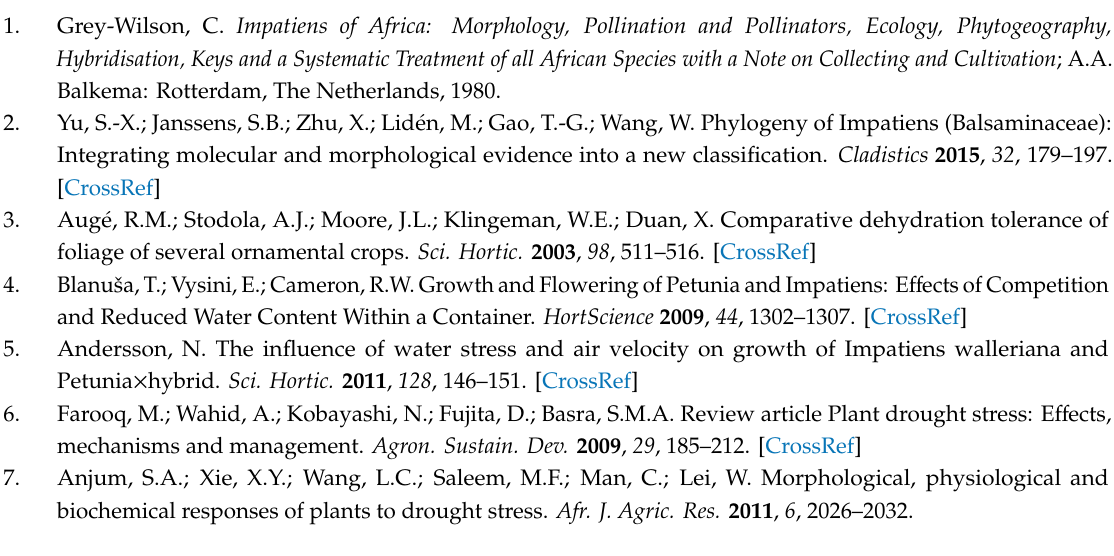
Table S1. Excel file containing transcriptome and dehydrins sequences details. Supplement 2. Table S2: Analysis of deviance table for flower and bud data modeled using Poisson regression with log link, Table S3: Analysis of deviance table for bud data modeled using Poisson regression with log link, Table S4: Analysis of deviance table for flower data modeled using Poisson regression with log link, Figure S1: Number of A—flower buds and B—flowers developed per plant, Table S2.4: Analysis of variance table (type I SS) for RWC, Table S6: Analysis of variance table (type I SS) for MDA, Table S7: Analysis of variance table (type I SS) for proline, Table S8: Analysis of variance table (type I SS) for IwDhn1, Table S9: Analysis of variance table (type I SS) for